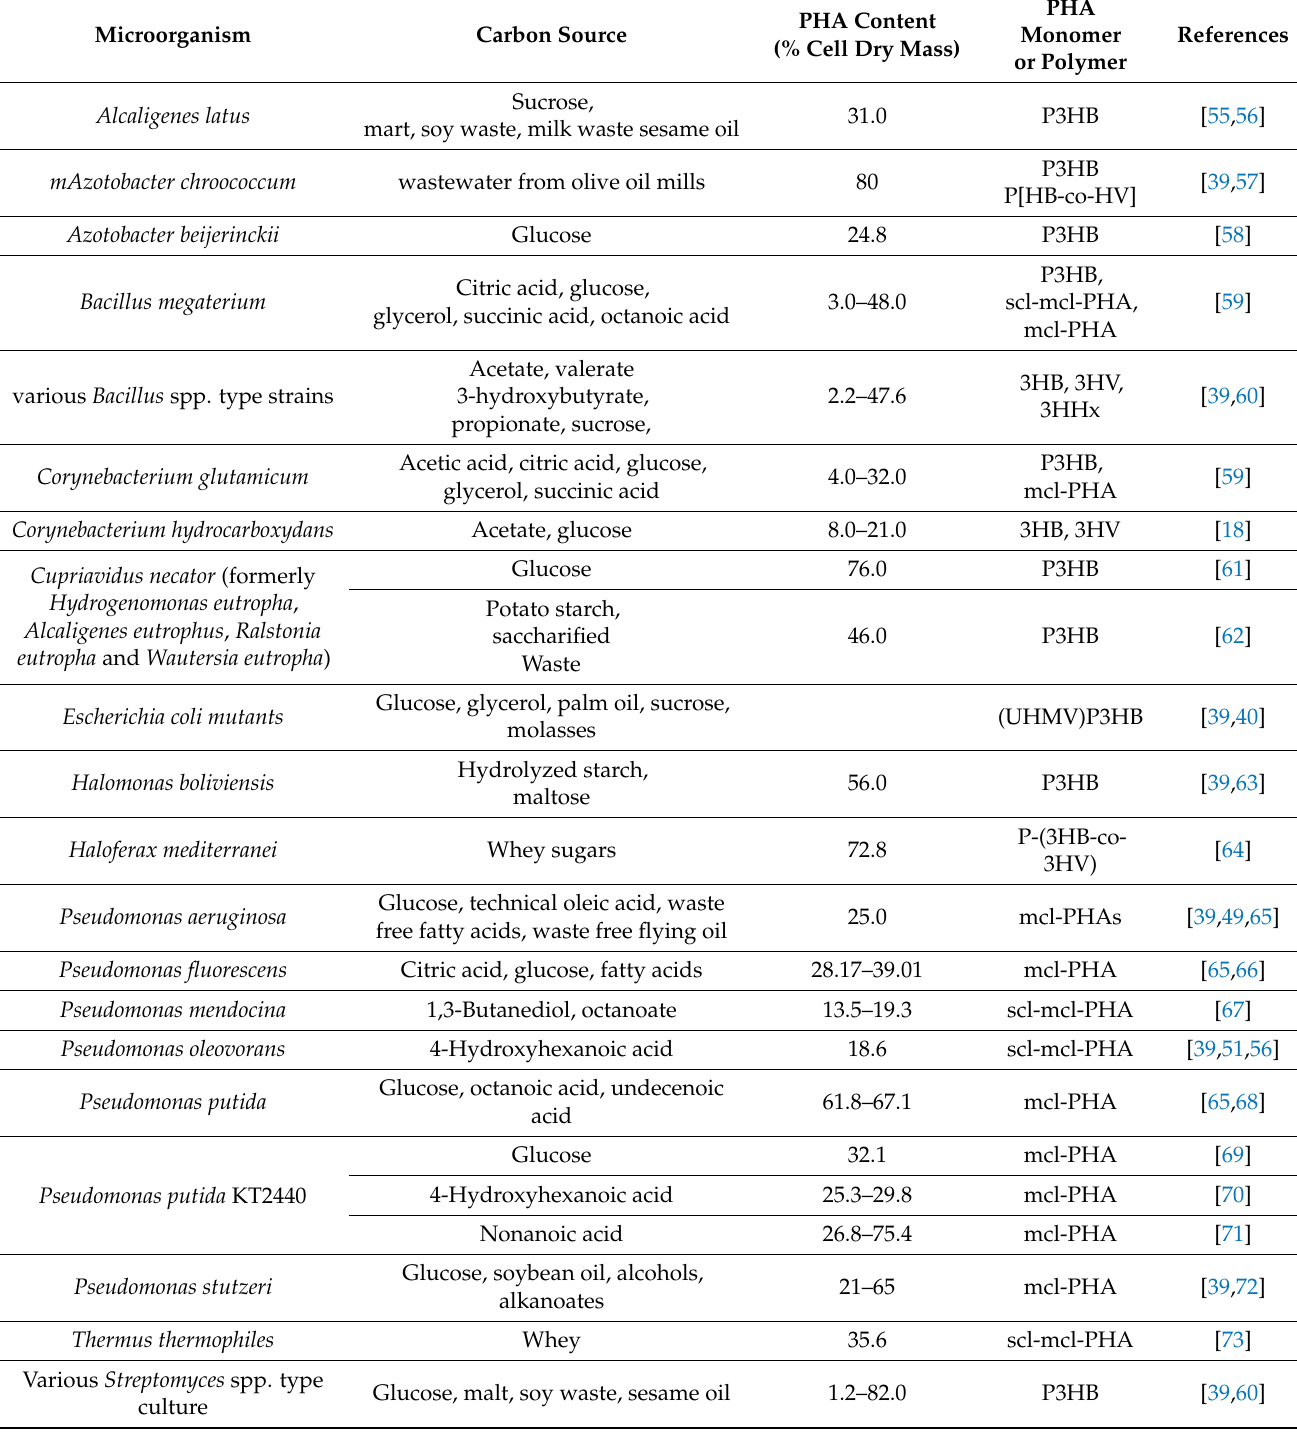
Table 2. Biosynthesis of PHA by various